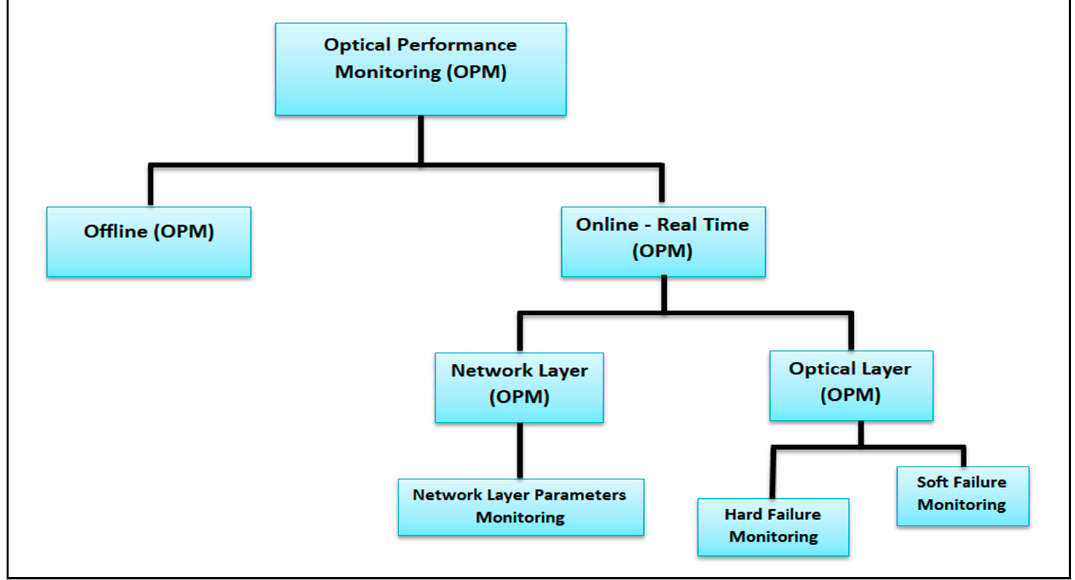
Figure 1. Optical performance monitoring classification.